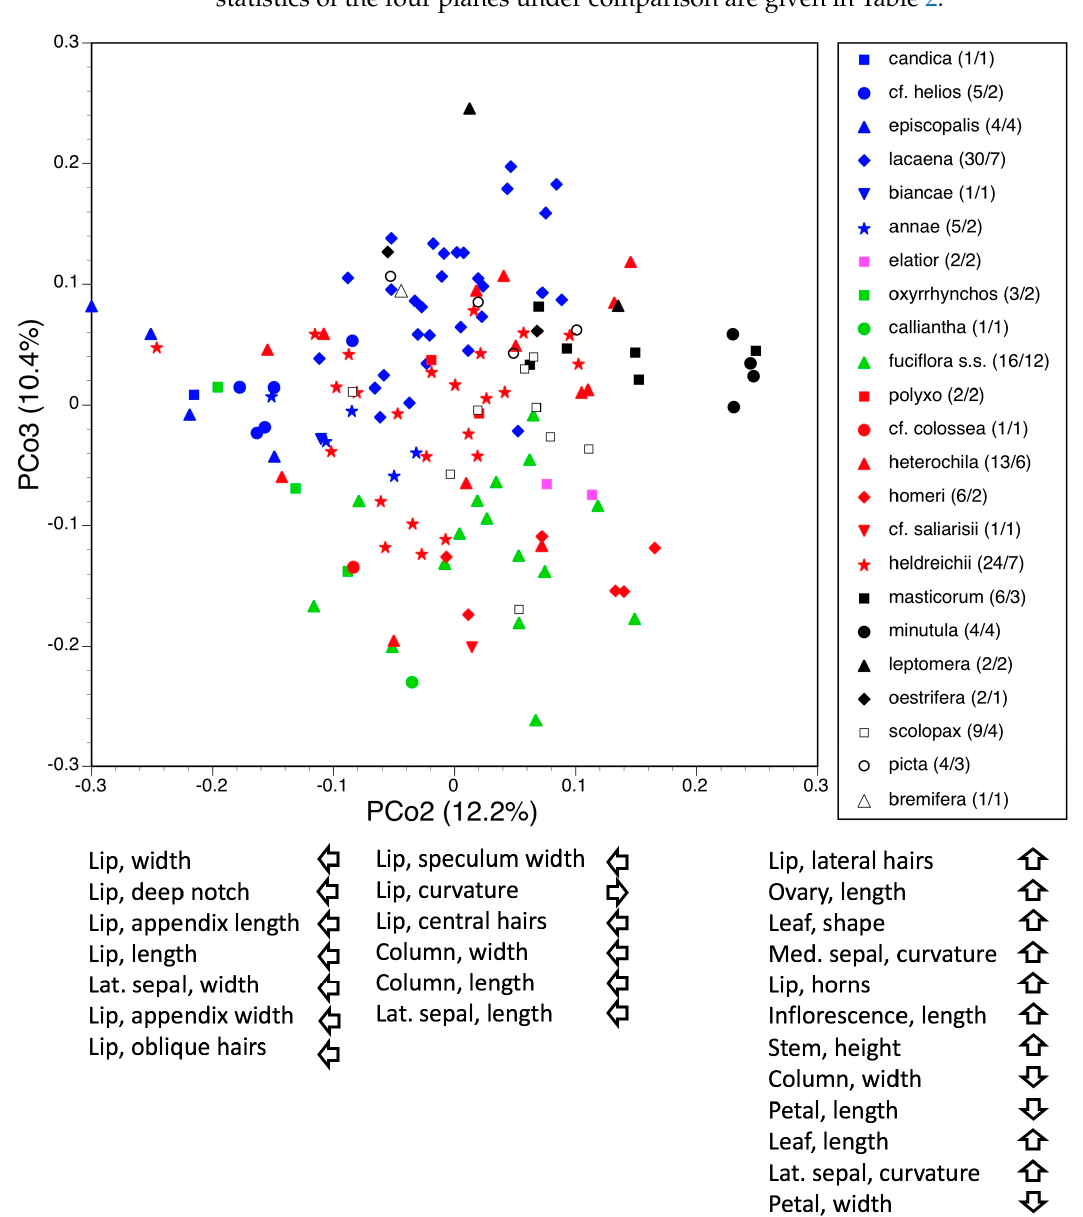
Figure 16. Plot of principal coordinates 2 and 3 for the macrospecies Fuciflora, labelled according to 23 microspecies (and six mesospecies, represented by identically coloured symbols): 143 individuals from 68 localities and 51 variable characters. Parenthetic numbers in the taxonomic key indicate the number of plants and localities respectively included in the analysis. Characters contributing to each coordinate are listed in descending order, with arrows indicating the direction of increase in the value of each character.